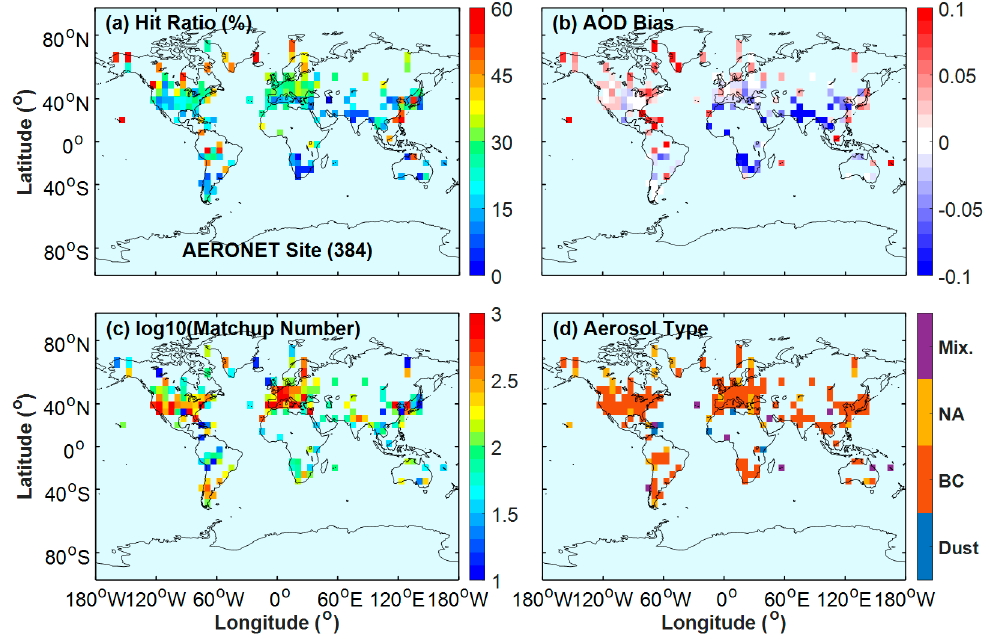
Figure 2. AERONET sites with more than 10 matchups applied in the study. All AERONET sites in a 6° × 6° grid box throughout the world: ( a ) hit ratio of aerosol type between VIIRS and AERONET; ( b ) AOD difference (VIIRS minus AERONET); ( c ) matchup number of VIIRS and AERONET; and ( d ) aerosol type with the highest frequency.